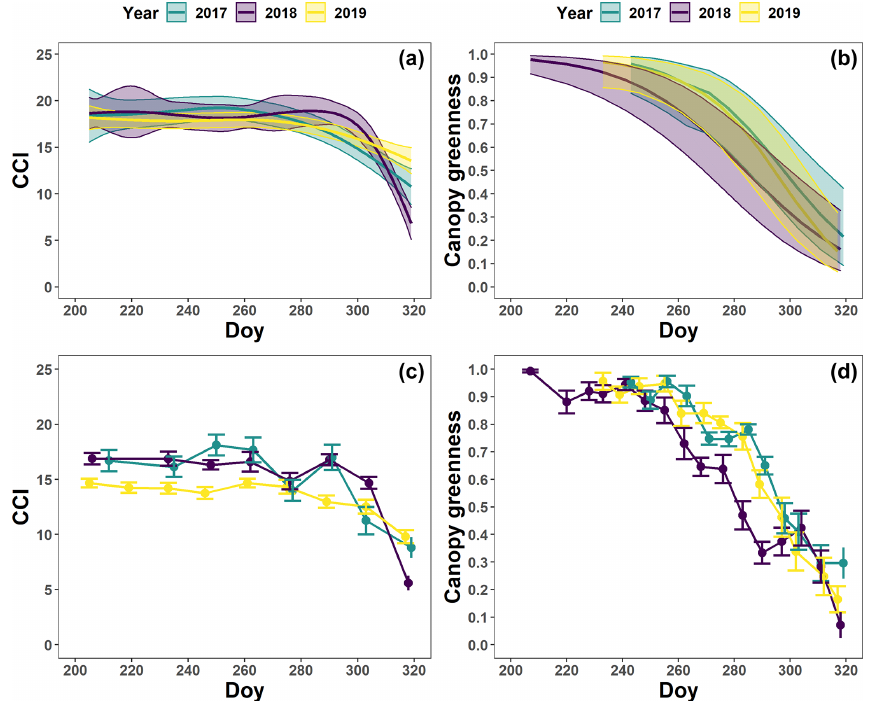
Figure 6. The generalized additive mixed model fits for the chlorophyll content index (CCI; n = 4; a ) and loss of canopy greenness ( n = 8; b ) of the mature Betula pendula trees at the Klein Schietveld. The solid colored lines represent smooth terms, while the colored shaded bands around the smooth terms represent approximate 95% simultaneous confidence intervals (a) and 95 % pointwise confidence intervals (b) . The dots and error bars represent the mean CCI (c) and mean canopy greenness (d) with standard errors. The colors represent the CCI or the loss of canopy greenness of the mature birch trees in 2017 (green), 2018 (purple) and 2019